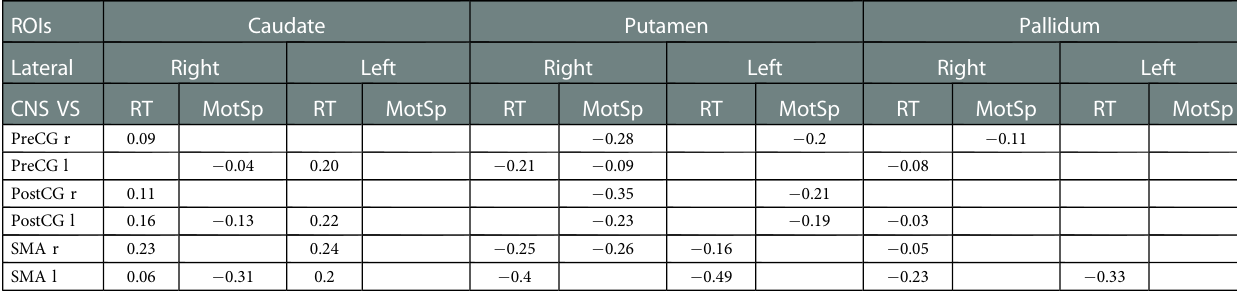
Spearman correlation coef fi cients (r) are shown in the matrix. Non-signi fi cant ( p (cid:1) FDR . 0 : 05) coef fi cients are left blank. An r closer to + 1 indicates a stronger correlation. Abbreviations: Abbreviation: PreCG r (Precentral Gyrus Right), PreCG l (Precentral Gyrus Left), PostCG r (Postcentral Gyrus Right), PostCG l (Postcentral Gyrus Left), SMA r (Supplementary Motor Cortex- Right), SMA L (Supplementary Motor Cortex-